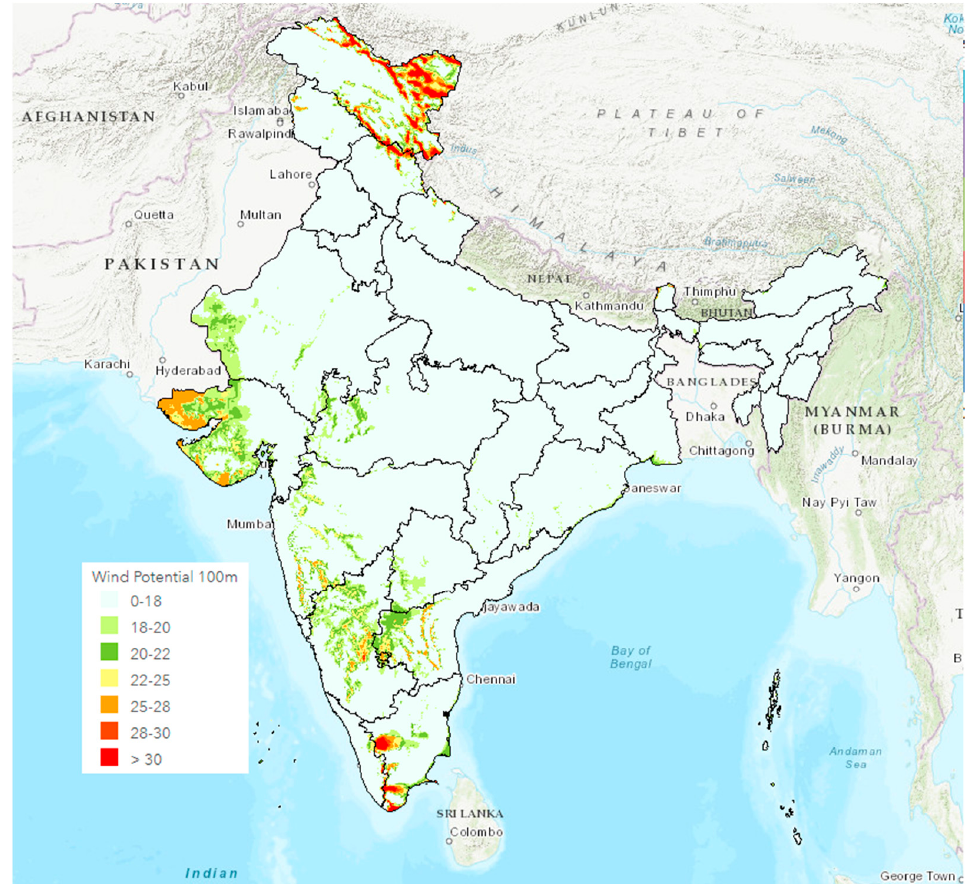
Figure 13. Map showing wind power density at 100 m AGL [58].